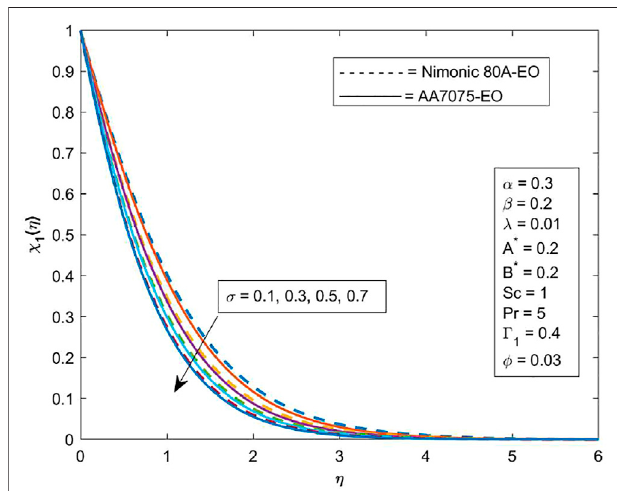
FIGURE 5 | Provocation of β on θ 1 .